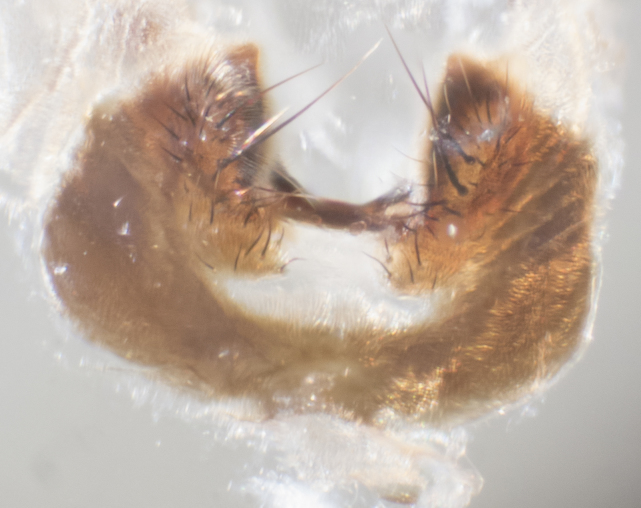
sternite 5, ventral view